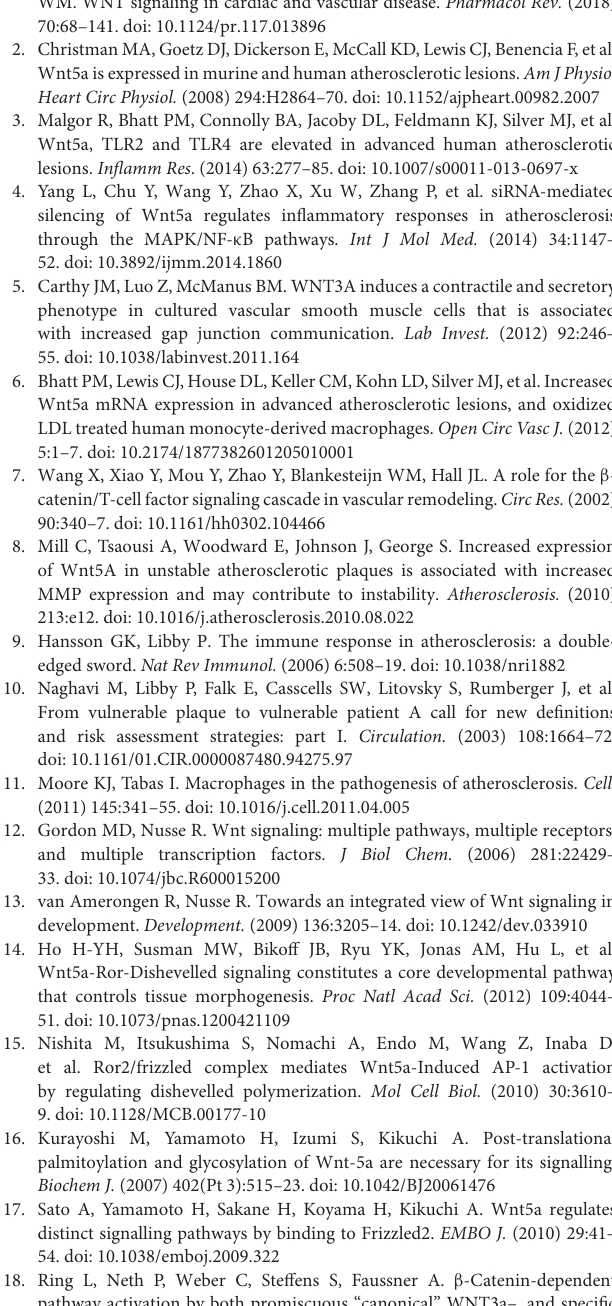
in the Materials and Methods section. Cells were counterstained with 4 ′ ,6-diamidino-2-phenylindole (DAPI) and images are at 600X (scale bar = 50 µ m). Quantification of lipid accumulation was represented as pixel intensity per cell as a measure of lipid droplet density and intensity. Data are representative of n = 2 experiments and are presented as bar graphs (mean ±